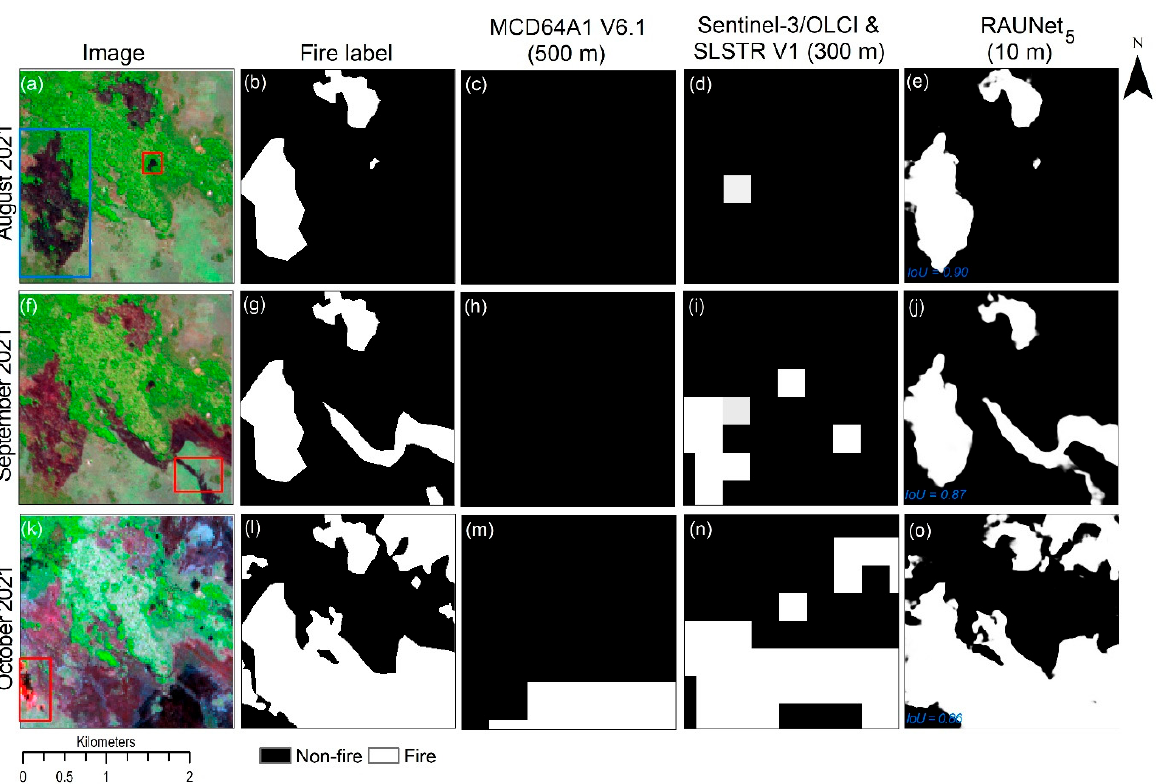
Figure 8. The performance of RAUNet 5 in detecting burned areas at different times within a specific image patch of the miombo ecoregion: the predicted fires using the product fires of MCD64A1 Version 6.1 (500 m), Sentinel-3/OLCI Version 1 (300 m), and our approach (10 m) in ( a – e ) August 2021, ( f – j ) September 2021, and ( k – o ) October 2021. The ( a ) very small fire in August and ( k ) active fire in October were only detected by ( e,o ) RAUNet 5 . Our model showed strong performance in depicting ( e ) the expansion of fires and ( j ) missing fires in its fire label.